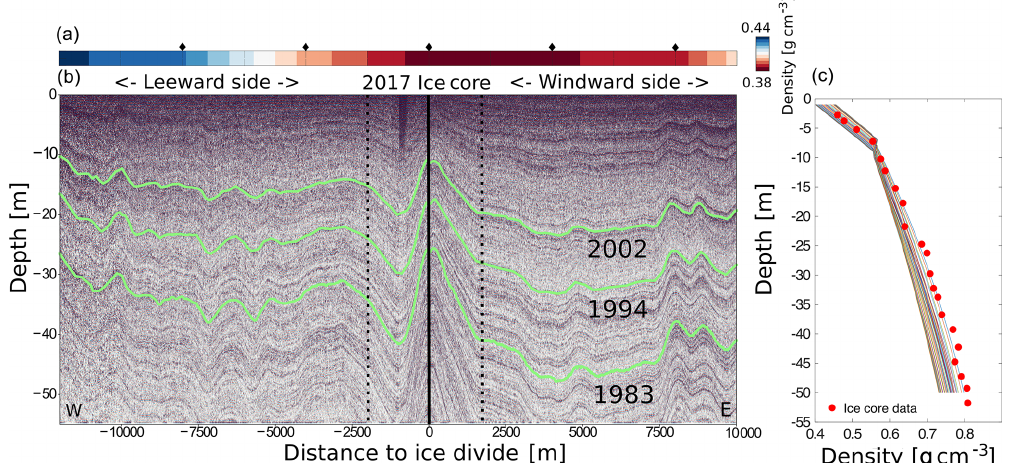
Figure 2. (a) Interpolated surface density, (b) GPR profile across the LIR from west to east (red line on the LIR in Fig. 1) and (c) the modeled density curves together with measured density from the FK17 ice core. The surface density is linearly interpolated from firn core measurements; the black diamonds mark the location of the firn cores. The black lines in (b) show the three tracked horizons together with their dating, and the vertical black line shows the location of the FK17 ice